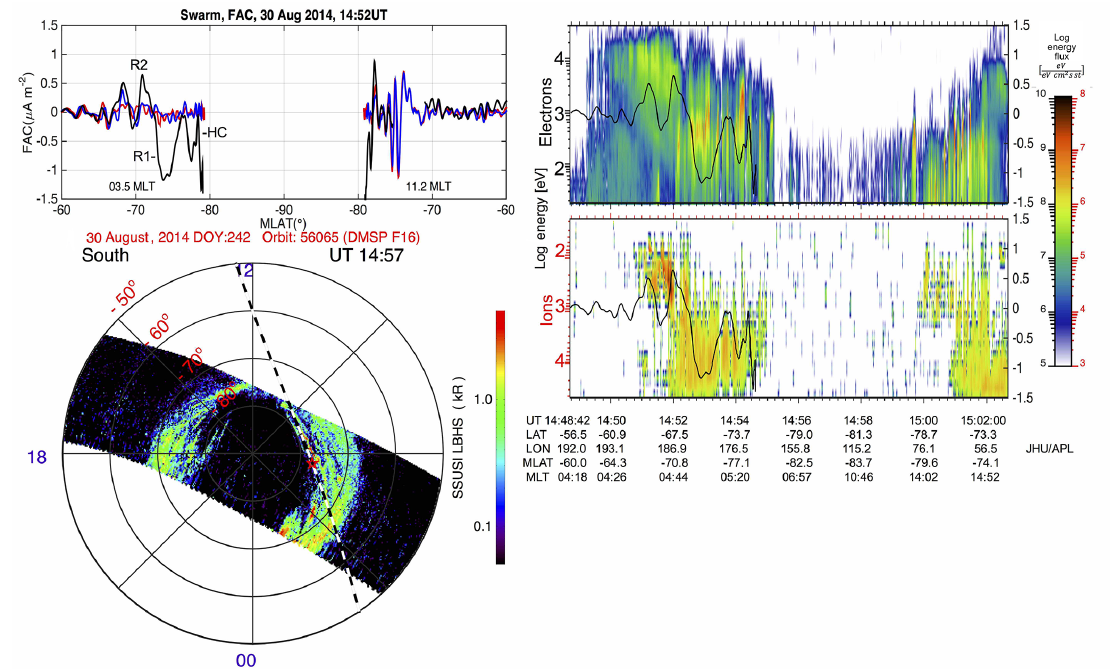
Figure 6. Same format as Fig. 5 but for 30 August